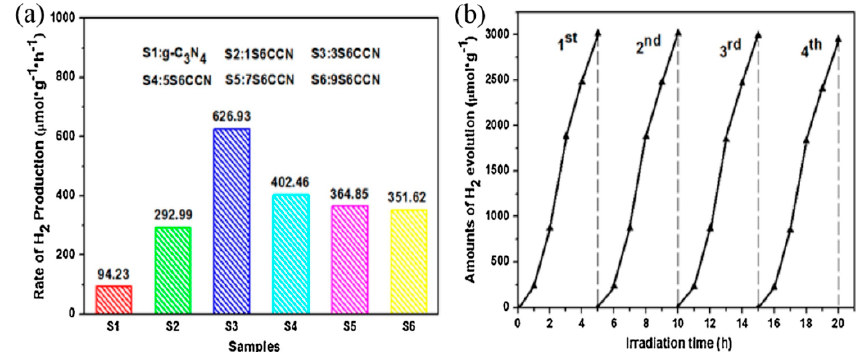
Figure 15. ( a ) Photocatalytic activity of pure g-C 3 N 4 and Ag NPs modified 6CCN (6 mL CQDs/g-C 3 N 4 ) composites with different contents for photocatalytic H 2 generation under visible-light irradiation, ( b ) Recycling performance of 3S6CCN towards photocatalytic H 2 generation (reproduced with permission from [89]. Copyright Elsevier, 2017).